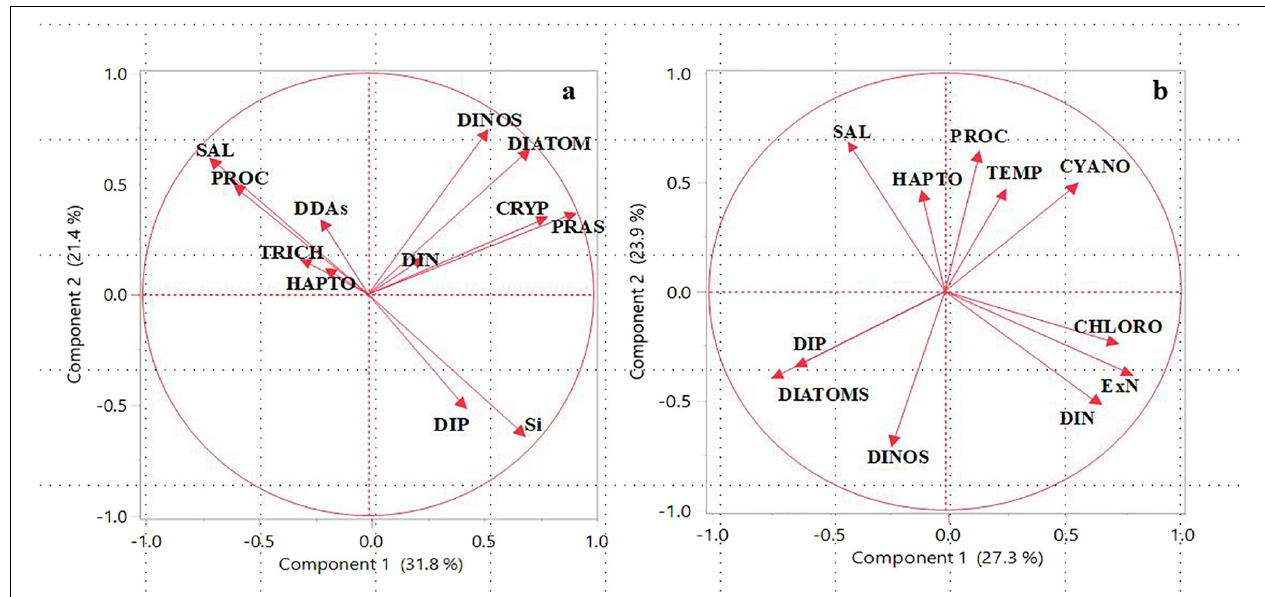
FIGURE 4 | Principal Component Analysis (PCA) of the hydrographic parameters (Temperature and Salinity), nutrients, and phytoplankton classes for (a) Amazon River Plume and (b) East China Sea. Abbreviations used: PROC ( Prochlorococcus ), DDAs (Diatom-Diazatroph Associations), TRICH ( Trichodesmium ), HAPTO (Haptophytes), DINOS (Dinoflagellates), CRYP (Cryptopytes), PRAS (Prasinophytes), SAL (Salinity), DIN (Dissolved Inorganic Nitrogen), DIP (Dissolved Inorganic Phosphorous), Si (Silicate), ExN (Excess Nitrate). Redrawn from Goes et al. (2014) and Xu et al.